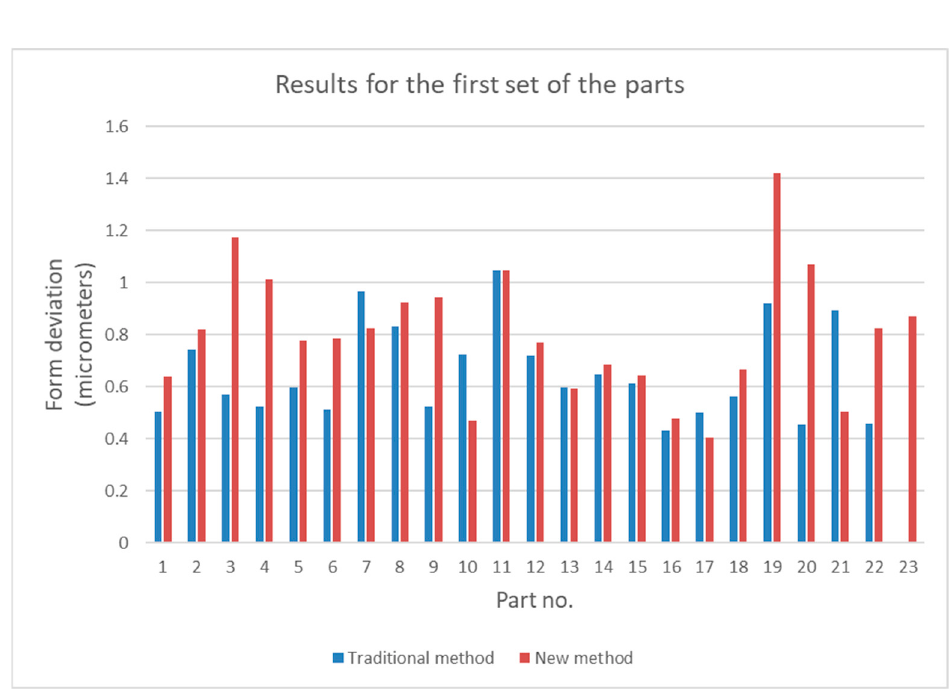
Figure 4. Comparison of form deviations obtained by the traditional and by the new method for the first set of parts.